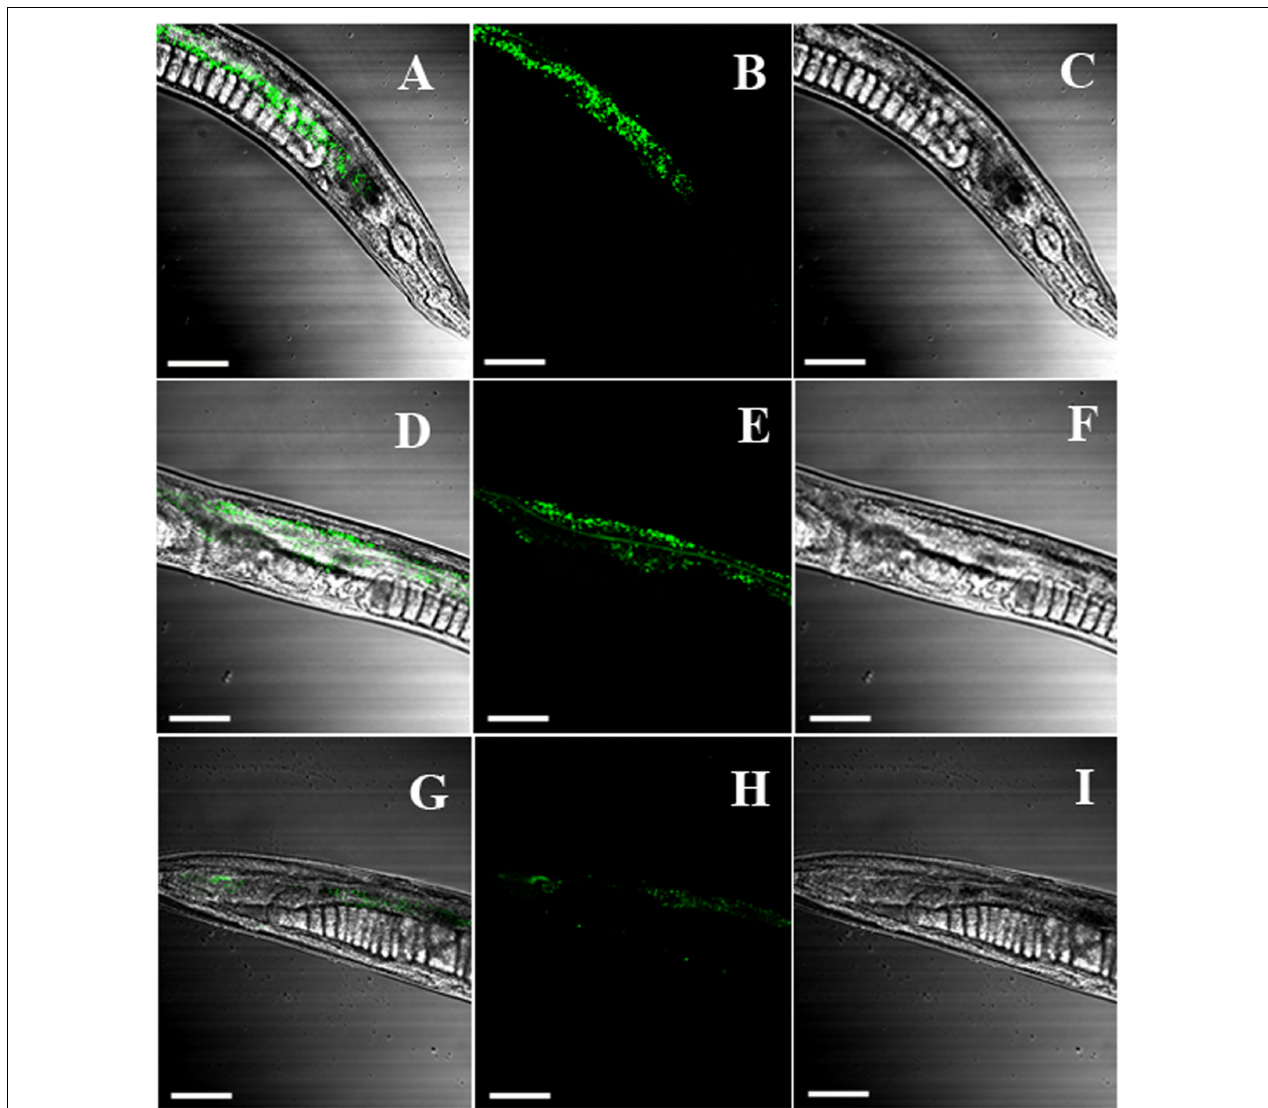
FIGURE 3 | Expression of Hc-daf-22 mutants in ok693 strain. Hc-daf-22 and three mutants were microinjected into the daf-22 mutant ( ok293 ). GFP expression of the F1 or F2 worms was examined under a confocal fluorescence microscopy. The microscopy showed GFP signals were detected in all four transformed lines and the expression patterns were identical. Here only the GFP expression of Hc-daf-22 -84S were presented as a representation. Hc-daf-22 -84S was expressed mainly in the intestine and partly in the pharynx and tail. (A–C) the view of GFP signal in the pharynx of the transformed worms; (D–F) intestine; (G–I) tail. Scale-bars : 100 µ m.